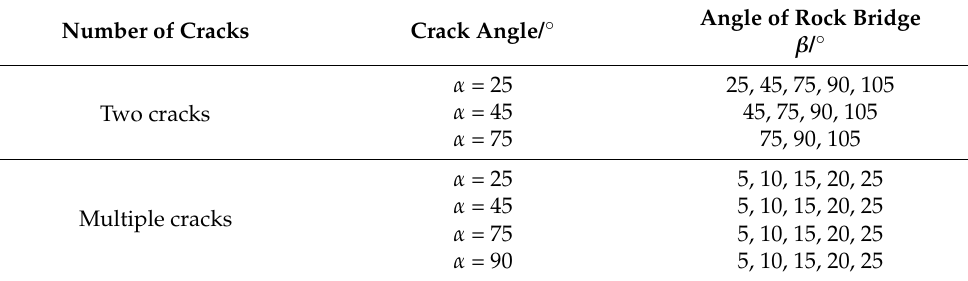
Table 1. Details of specimens containing multiple cracks.